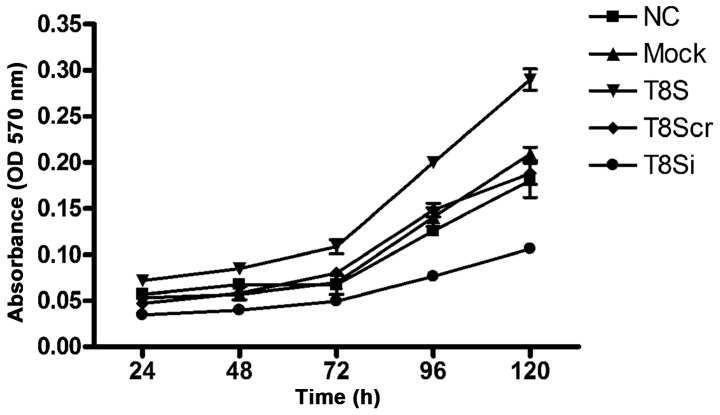
Effect of β1,3-N-acetylglucosaminyltransferase-8 (β3GnT8) on the proliferation of U251 cells in vitro. Cell proliferation was investigated by MTT assay at different time-points after culture at 24, 48, 72, 96 and 120 h.